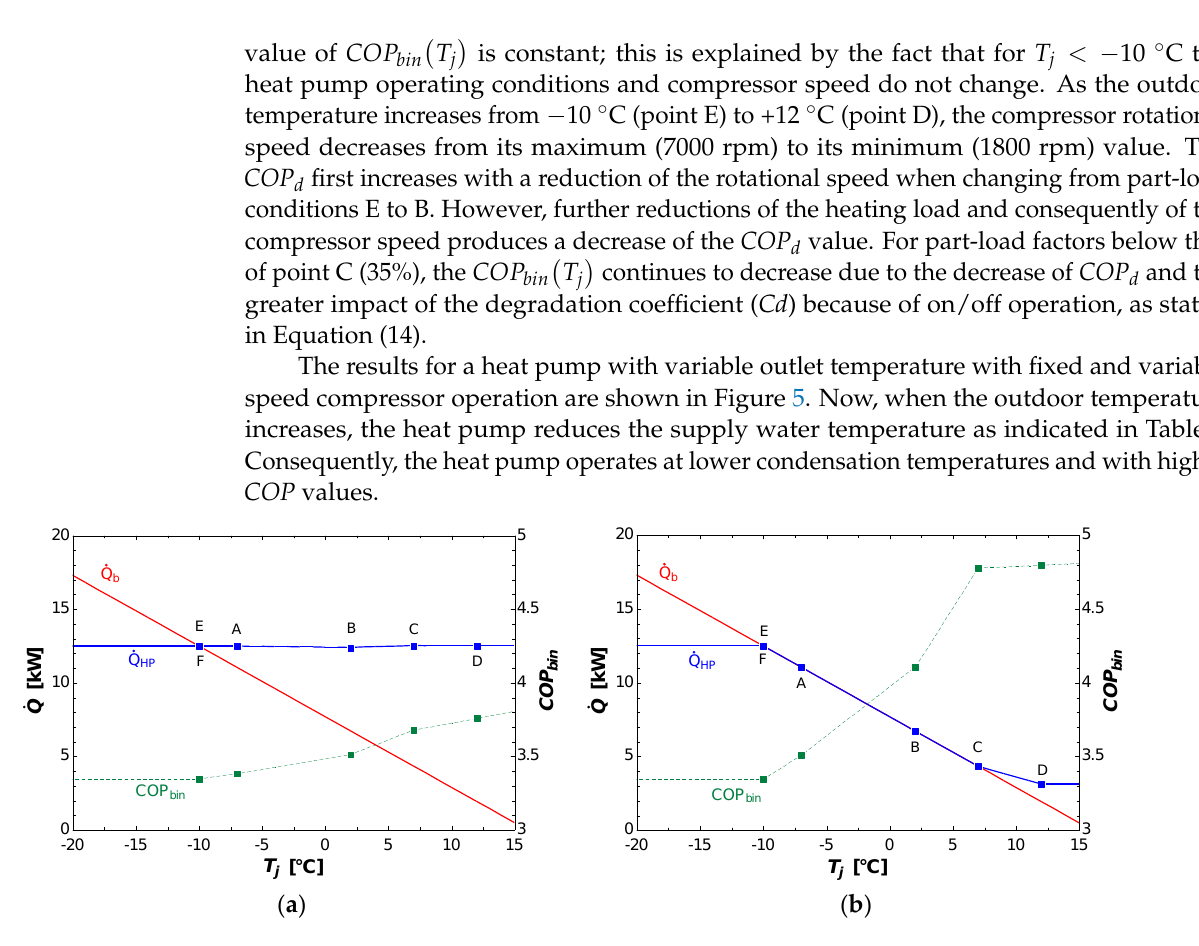
Figure 5. Heating load curve, heat capacity curve, and COP bin of the heat pump as a function of the outdoor temperature for a heat pump with variable outlet temperature and ( a ) a fixed speed compressor, ( b ) a variable speed compressor.